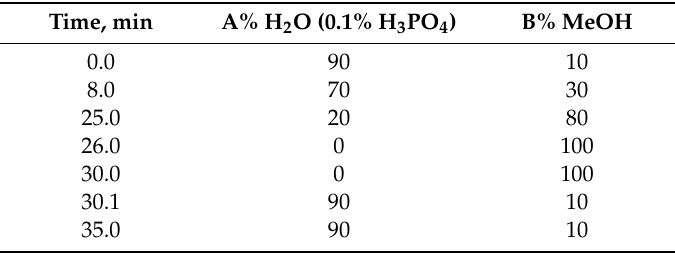
Table 1. Gradient regime of